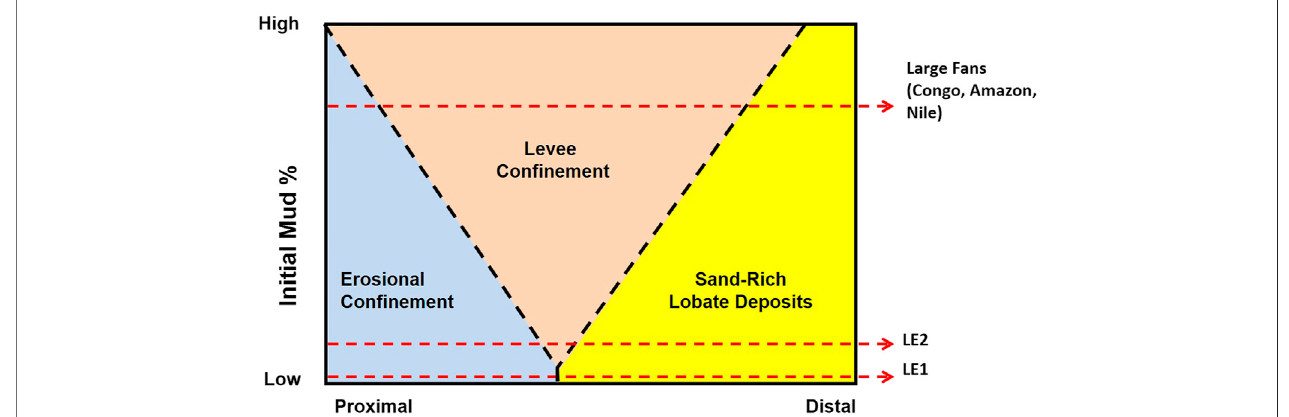
FIGURE 13 | Simpli fi ed schematic fi eld diagram of the gross architectural succession from proximal to distal of a submarine turbidite system as a function of the abundance of initial mud in the average turbulent fl ow. Boundaries between fi elds are displayed as a linear function for simplicity but we acknowledge that these boundariesmaybenon-linear.Themodelisscaleindependent.Gradientisnotconsidered hereexplicitlybecausemud-richsystemsrespondtogradient verydifferently than sand-rich systems. Mud is assumed to be located primarily in the upper dilute portion of highly strati fi ed turbulent fl ows and to be consumed during transport primarily due to levee construction that shortens fl ow height. Levees decrease in height and decrease contribution to con fi nement down fl ow. Substrate entrainment is not considered. Also, this model does not consider the contribution of debris fl ows (LE3 does not apply). This model illustrates that systems with relatively high initial volumes of mud (higher on the Y axis) extend farther into the basin (more ef fi cient) and tend to have larger sediment volume, larger levee volume, and more extensive levee-con fi ned distributaries. Systems with relatively low initial volumes of mud (lower on the Y axis) extend a shorter distance into the basin (less ef fi cient) and tend to have smallersedimentvolume, smaller levee volume, increased reliance on erosional con fi nement, increased tendency to collapse, and increased sensitivity to gradient. Mud-rich systems, such as the Amazon, Nile or Congo Fans, are dominated by large levee-con fi ned channels arranged in a distributary pattern. Extremely sand-rich systems, such as LE2 and Lobe X, are small, fed by erosional feeder channels with little to no distributary channels.